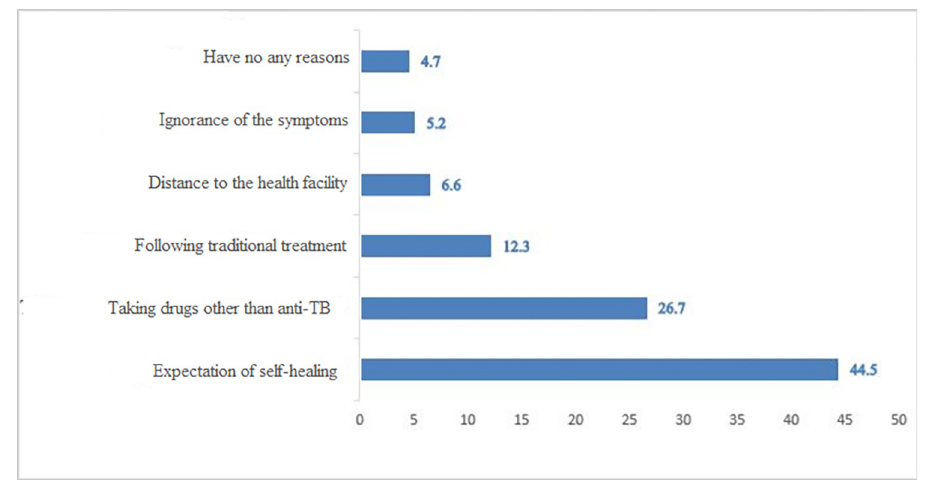
Fig 3. Participants’ reason for delays of EPTB diagnosis at public health facilities of North Shewa zone, Ethiopia, April 2021.